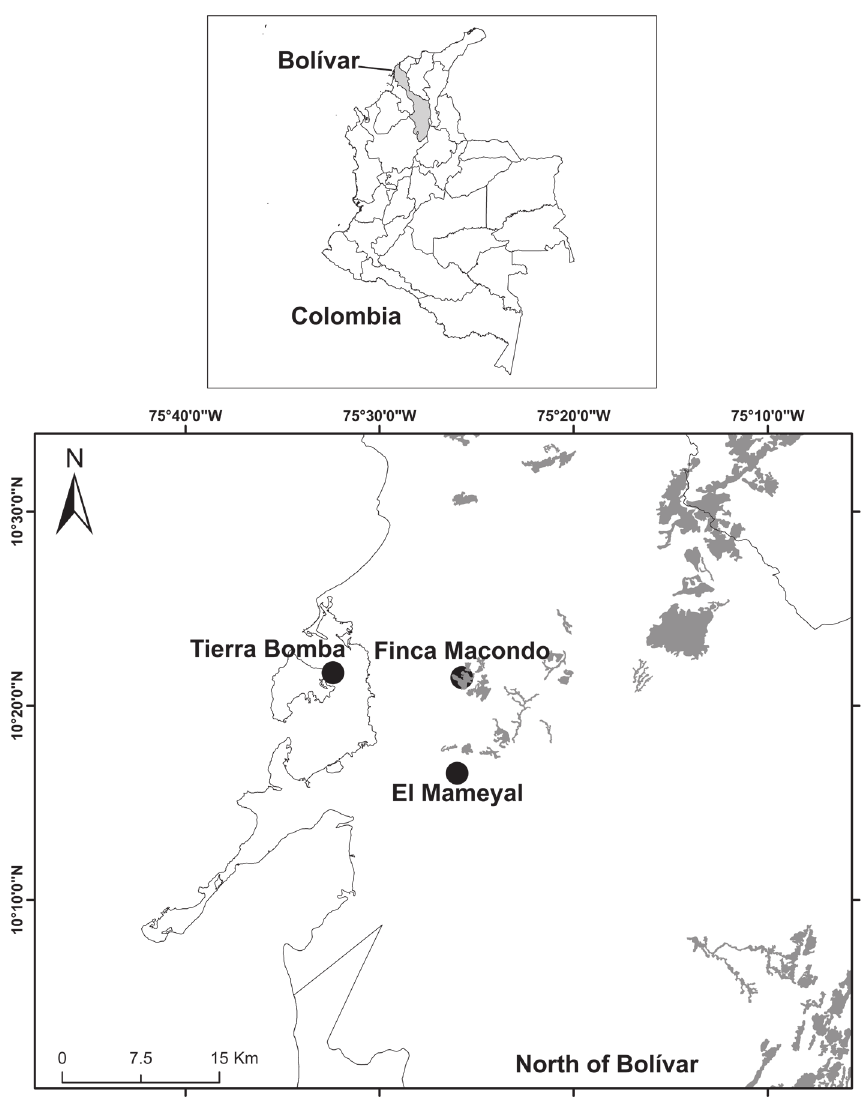
Figure 1. Distribution map of Pulmoniscus turbanaensis n. sp. Dark grey areas = Tropical Dry